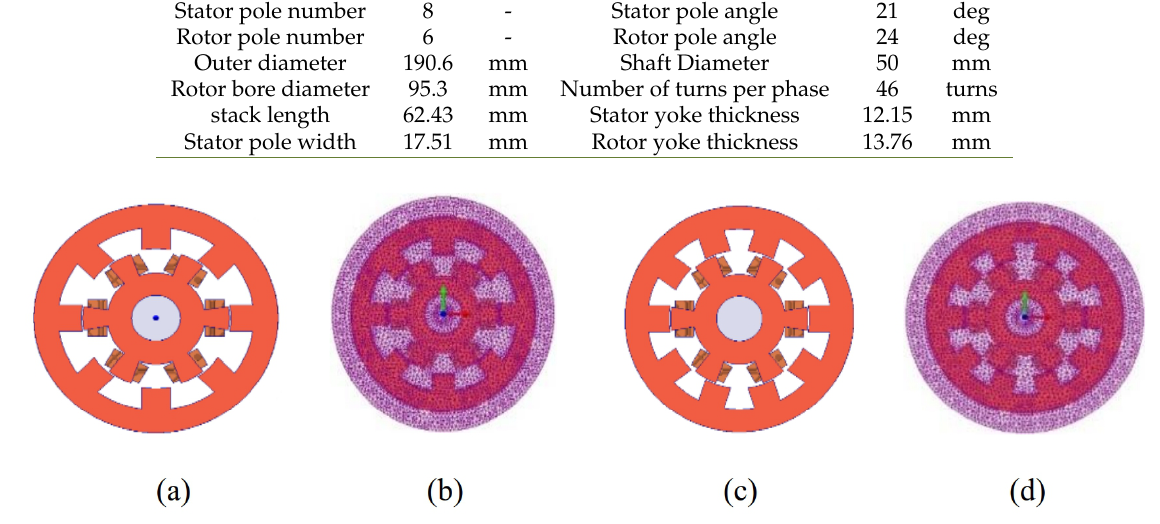
Fig. 3. Schematic diagram (a) 8/6, (c) 10/6 and Mesh node (b)8/6, (d)